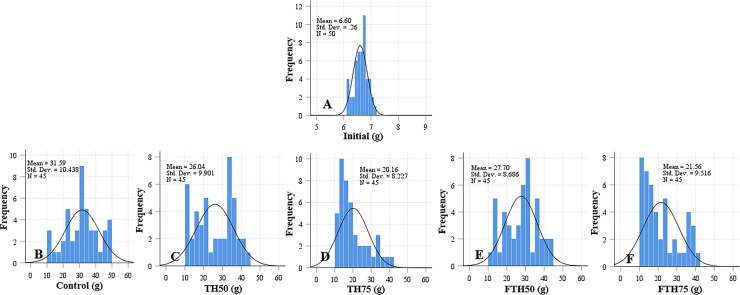
Weight distribution of initial fish and fish (A) and fish fed on TH diets (B–F) without or with fermentation after 56 days.Frequency distributions of control and TH50 and FTH50 fish skewed negatively indicates a higher proportion of large-body species and fish from TH75 and FTH75 groups skewed positively indicate small-body species within the distribution. n = 50 for initial fish (A), n = 45 for each experimental treatment (B–F).